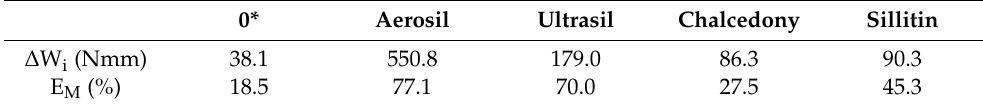
Table 5. Hysteresis losses and Mullins effect of unfilled and filled CR/BR/nano-Fe 2 O 3 vulcanizates. 0* Aerosil Ultrasil Chalcedony Sillitin ∆ W i